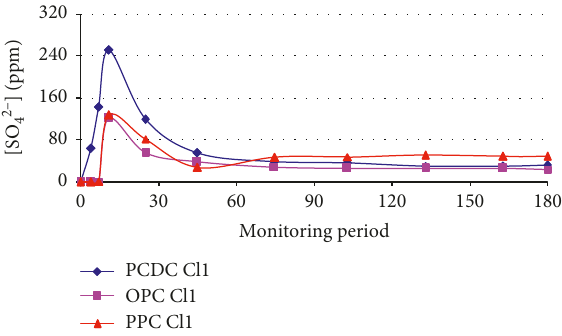
Figure 3: SO 42 analyses in chloride-simulated solution −